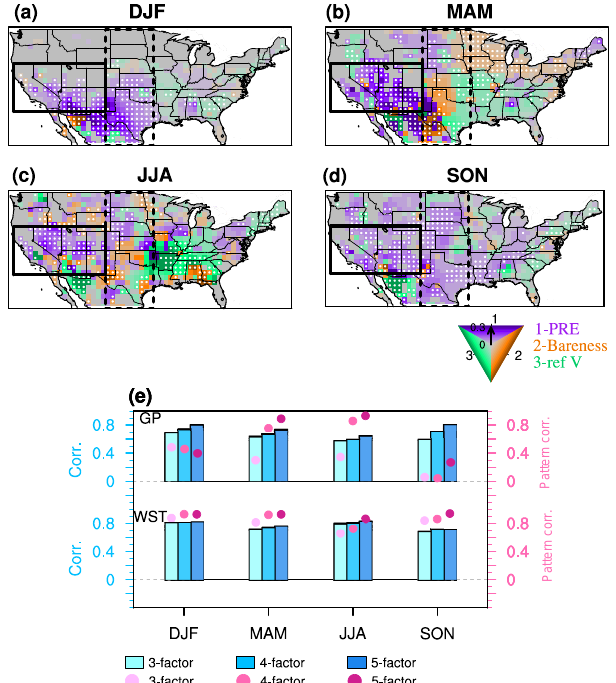
Figure 2. (a–d) Multiple-linear regression coefficients calculated by regressing fine dust concentration from 1990 to 2015 onto stan- dardized precipitation (purple), bareness (orange), and surface wind (green). Color denotes the most influential factor at each grid (i.e., the largest regression coefficient in absolute value among the three), while saturation of the color shows the magnitude of the coefficient (0 to 0.3). Areas significant at the 95% confidence levels are dot- ted. (e) Bar plot showing the correlations between observed regional mean fine dust concentration and the reconstructed concentration using three, four, and five controlling factors (light, median, and deep blue), and pattern correlation between trends from the observa- tion and from reconstructed fine dust using three, four, and five fac- tors (light, medium, and deep pink) in the Great Plains (GP) and the southwestern US (WST, black boxes in panels a–d ). “Three-factor” denotes precipitation, bareness, and surface wind; “four-factor” de- notes precipitation, bareness, surface wind, and CIN; “five-factor” denotes precipitation, bareness, surface wind, CIN, and CAPE. Black boxes denote the averaging areas of the WST (solid) and GP